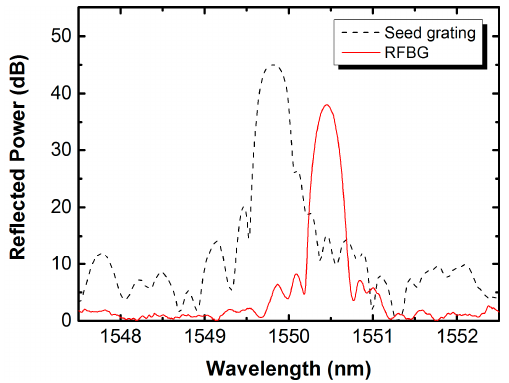
Figure 7. Reflection spectra of the typical type-I seed fiber Bragg grating (FBG) and its corresponding RFBG in H 2 -loaded PS1250/1500 fiber measured at room temperature (21 °C).